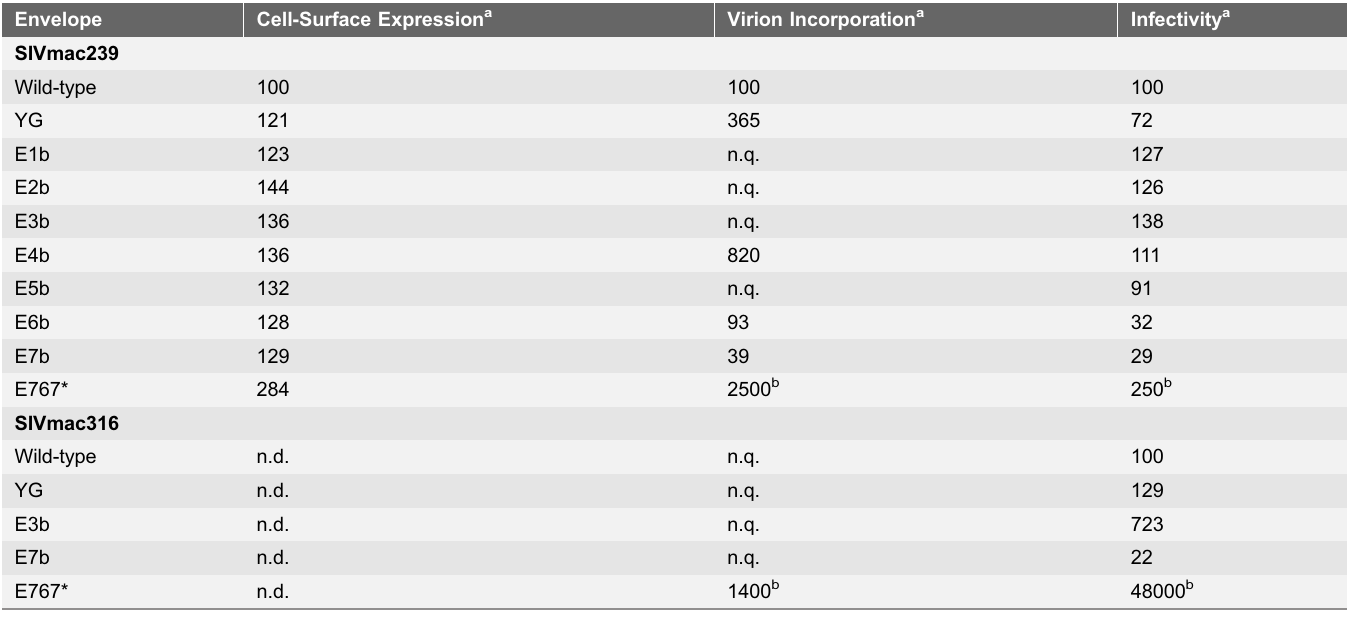
Table 1. Summary of phenotypes associated with mutation of potential trafficking motifs in gp41CD.